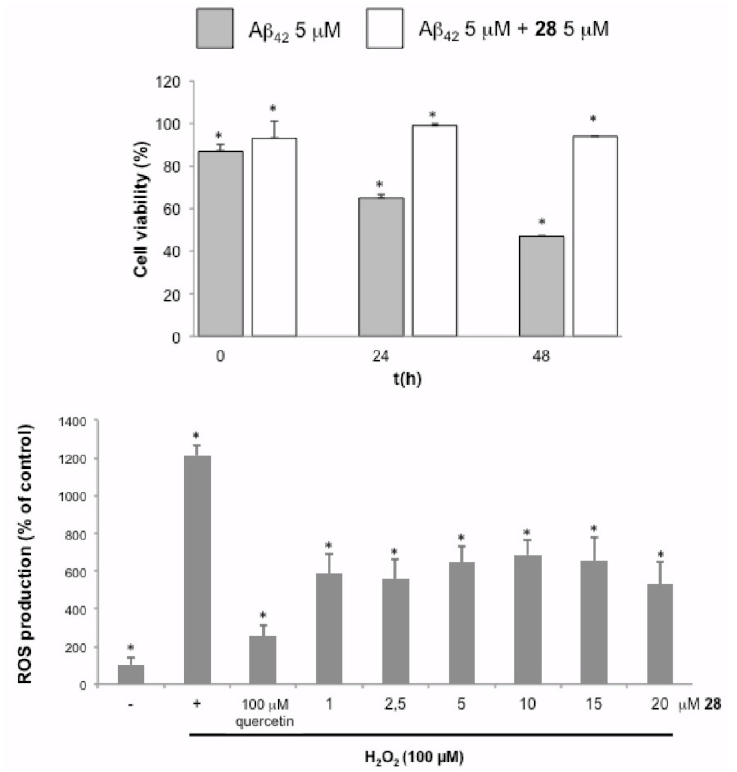
Figure 5. Cytoprotection of SH-SY5Y cells by compound 28 . Top, viability of cells at 0, 24 and 48 h incubated with 5 μ M A β 42 alone (grey bars) or in coincubation with equimolar 28 (white bars). The percentage of MTT reduction is relative to control cells. Bottom, radical scavenging activity of increasing concentrations of 28 (0 to 20 μ M) in the presence of 100 μ M hydrogen peroxide (DCFH-DA assay; control ( − ): non-treated cells; (+): positive control). Values are expressed as mean ± S.E.M. from six replicates, significantly different from control (untreated cells) as estimated by the Student’s t test (* p < 0.01).